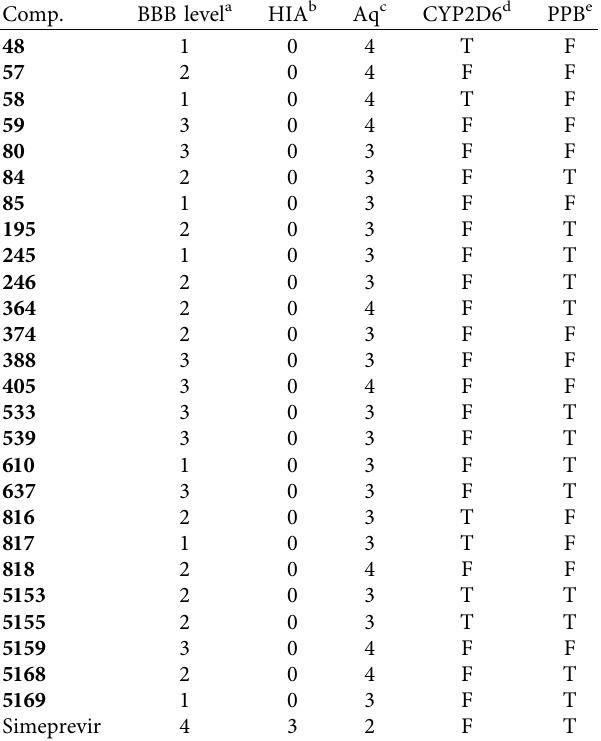
Table 4: ADMET profile of the 26 compounds with the best docking scores.